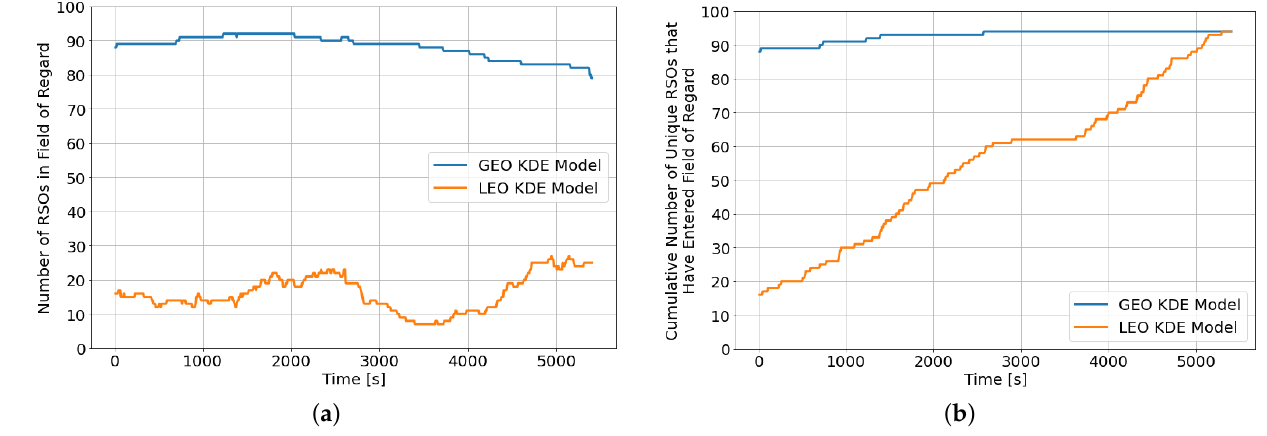
Figure 9. RSO distribution for population initialized for different orbital regimes. ( a ) Number of RSOs in field of regard; ( b ) Cumulative number of unique RSOs in field of regard since the beginning of the